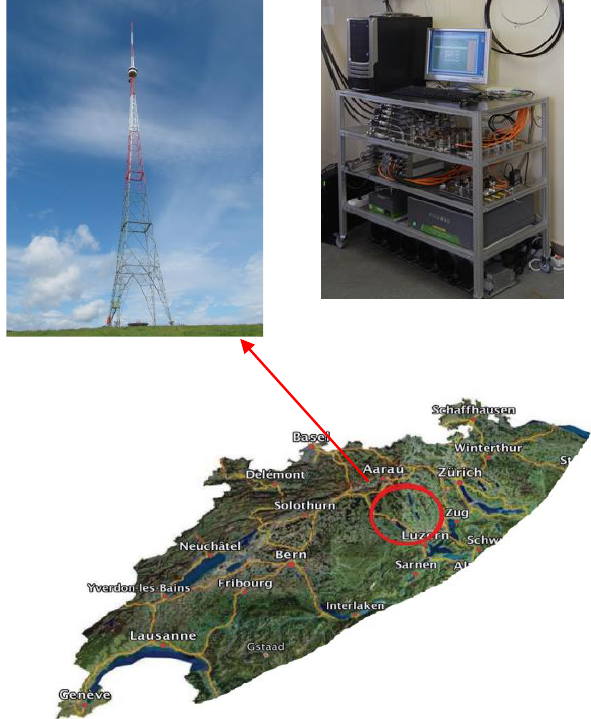
Figure 1. Geographical location of the Beromünster tall tower and pictures of the tower and of the measurement rack with the Picarro G-2410 CRDS analyzer on the lower shelf and electronics, flow control, and computer on the upper